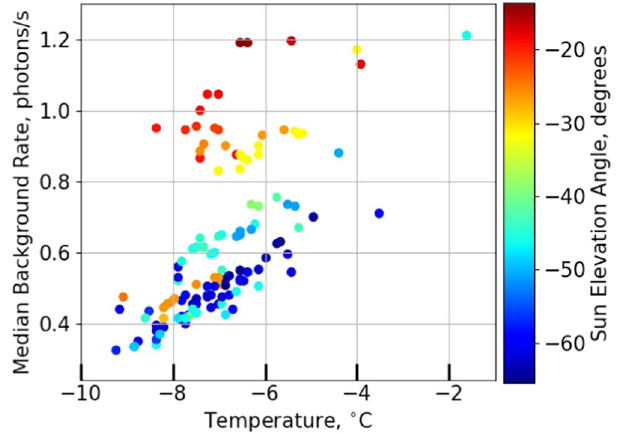
Figure 11. Jitter histogram for 254 × 300 s science exposures from the WASP- 189b campaign. The pointing sample rate is 5 s for each 300 s observation. Histogram bin widths are 0 5 for jitter < 10 ″ and 1 ″ for jitter > 10 ″ . A vertical dashed line indicates the cutoff used to eliminate low signal-to-noise observations from light curve